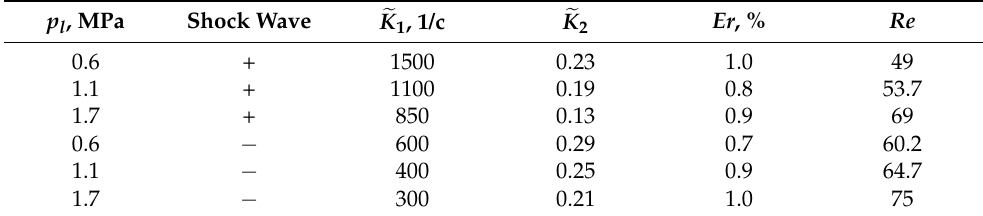
Table 4. Coefficients of the mathematical model at M = 3.0.